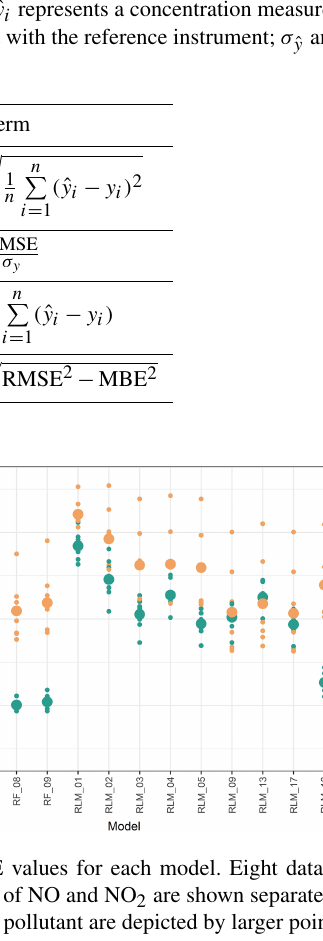
Figure 3. Box plots of nRMSE by (cid:49)t 0 of D RH . Five models (four RLM and one RF model) were considered for a (cid:49)t 0 ; hence 40 data points are contained in each box plot.